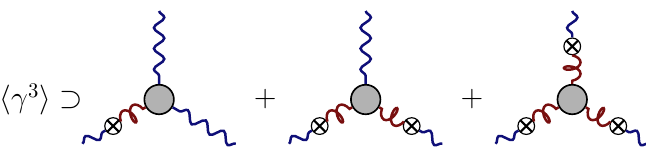
Figure 4 . Partially massless spin-2 contributions to a factor of Re